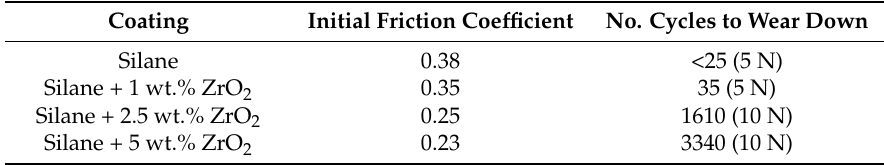
Table 4. Friction coefficient and number cycles to wear down for the